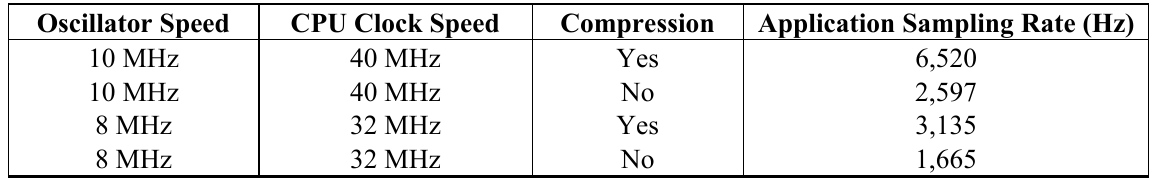
Table 2. Sensory Data Sampling Rate.